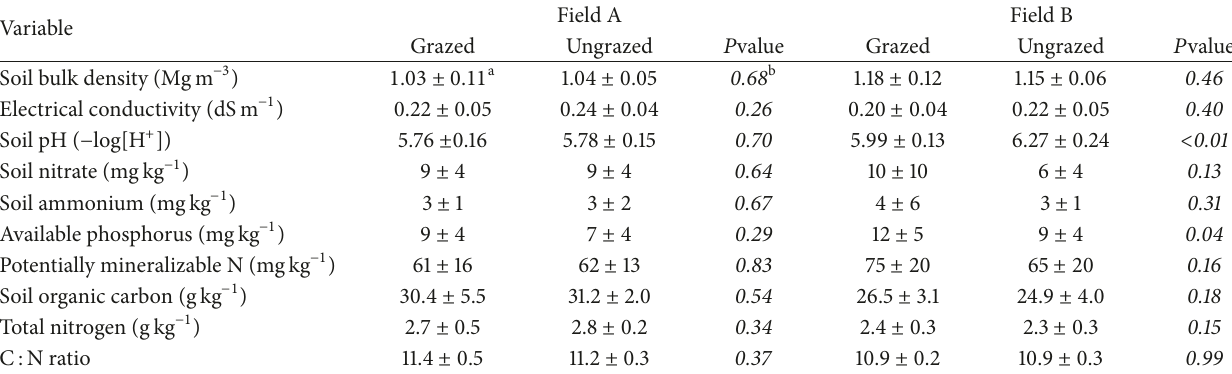
Table 5: Mean values of near-surface soil properties within annually cropped fields according to grazing treatment.